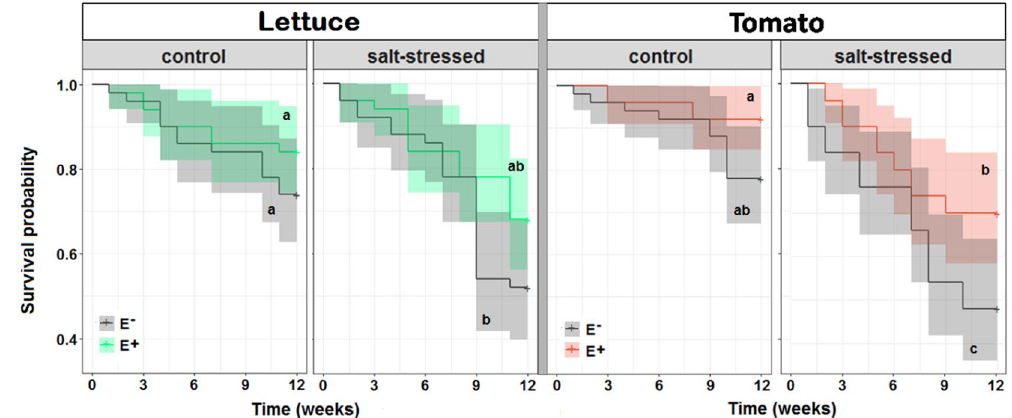
Figure 2. Temporal development of the survival rate of lettuce (left) and tomato plants (right) in the presence (E + ) or absence (E − ) of endophytes under salt stress (150 mM NaCl) and in control conditions (50 mM NaCl). For each condition, 50 plants were selected and their survival was monitored over time.